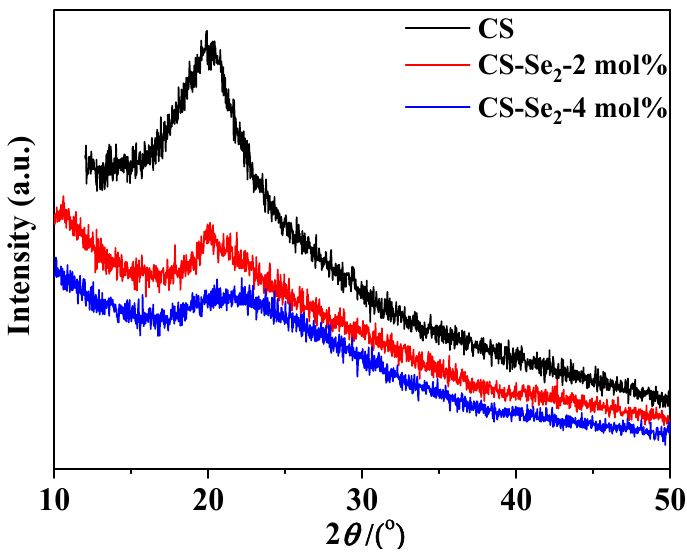
Figure 1. XRD patterns of chitosan (CS) and 2 mol%, 4 mol% Se-containing chitosan hydrogels.